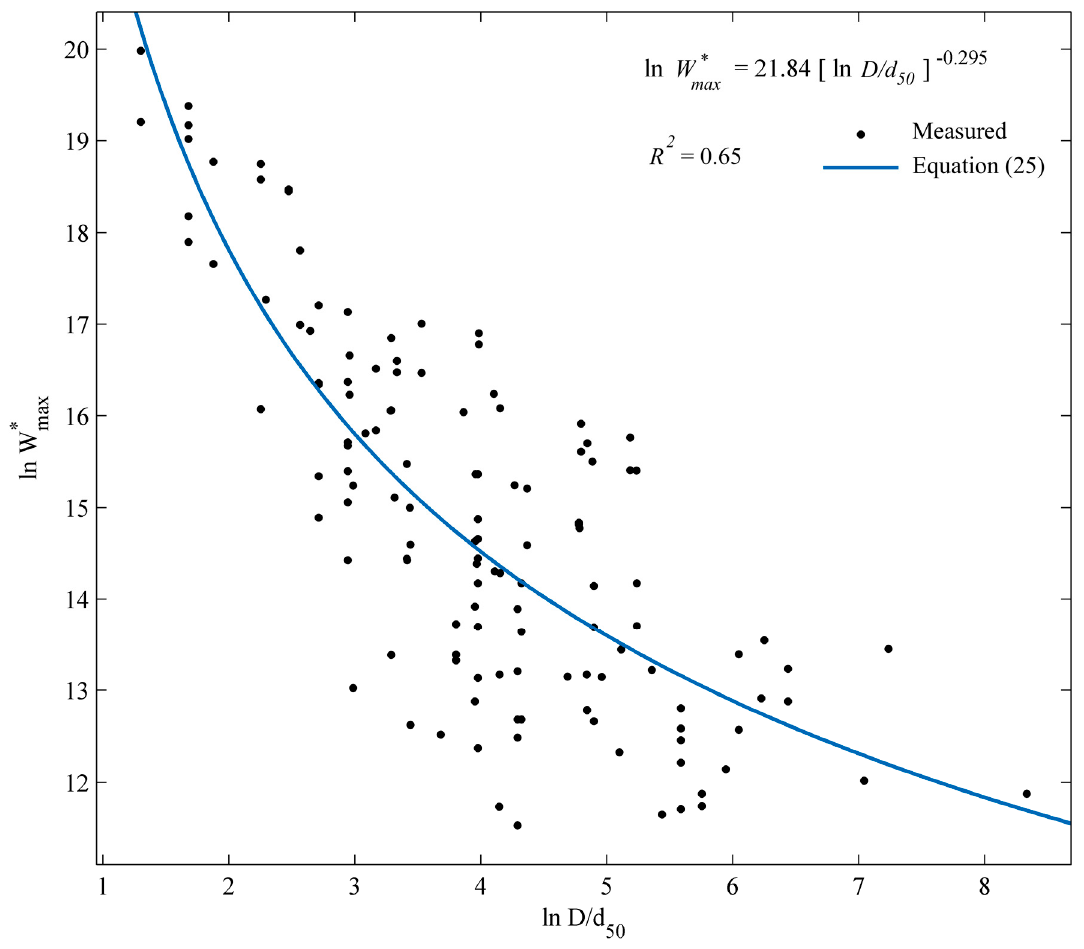
15 of 21 Table 4. Summary of the filtered experimental data. Data source: Sheppard et al. [9]. Author Number of Runs Range of Selected Dimensionless Parameters (cid:2160) (cid:2186) (cid:2782)(cid:2777) ⁄